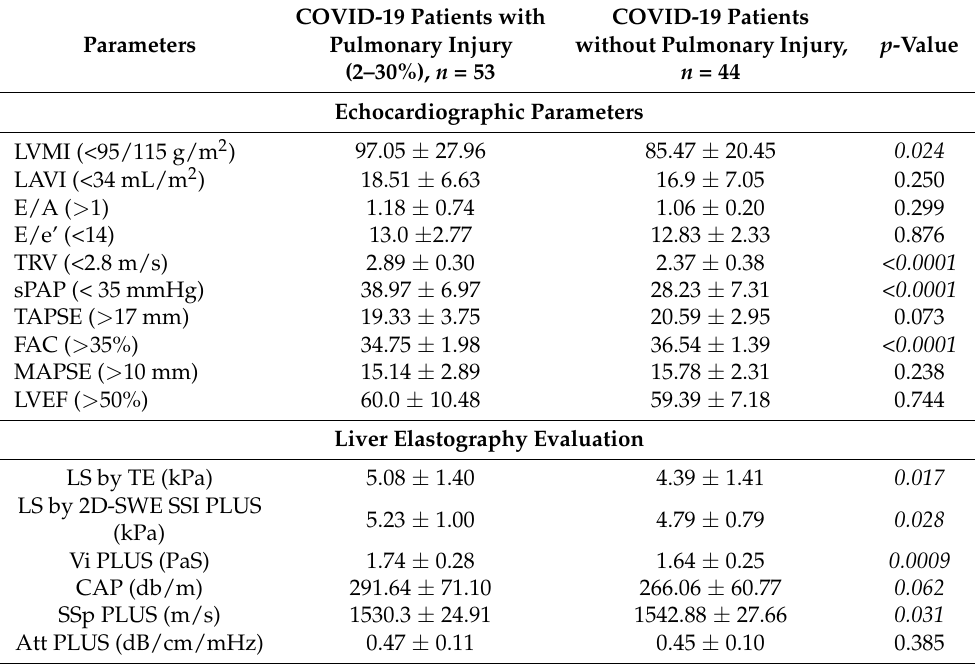
Table 2. TTE and liver elastography parameters according to the presence of pulmonary injury.